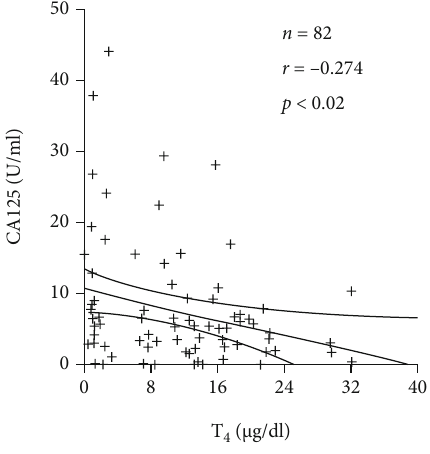
Figure 6: Graph showing the correlation between CA-125 and T4 concentrations in patients with altered thyroid states, demonstrated by Hashimoto et al. in their published article. Changes in tumor marker concentration in female patients with hyper-, eu-, and hypothyroidism